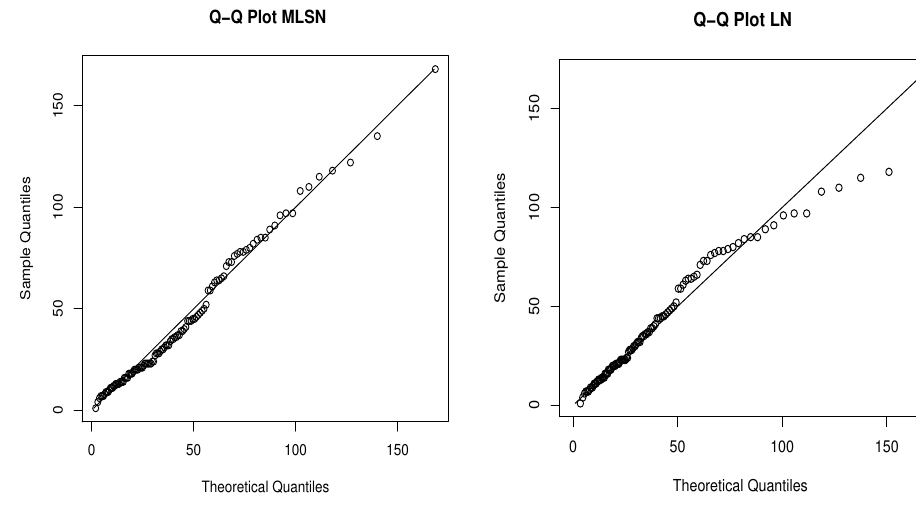
Figure 6. Left panel : QQ-plot for the MLSN model. Right panel : QQ-plot for the LN